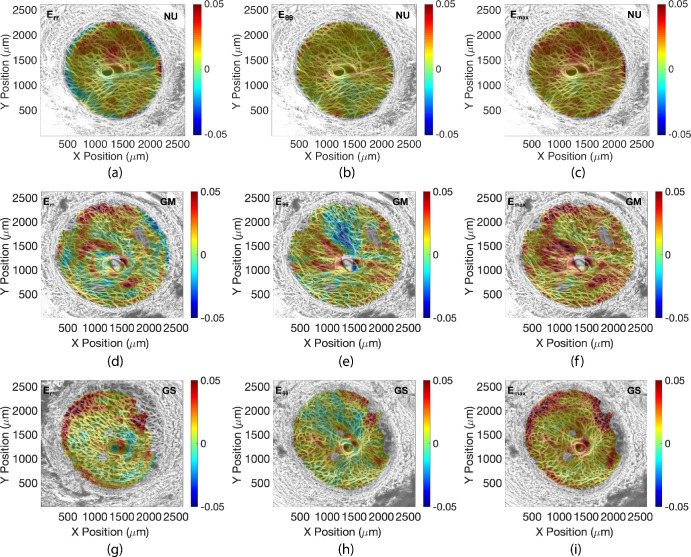
Comparison of strain within the LC of eye 6 (normal undamaged), eye 17 (glaucoma undamaged), and eye 14 (glaucoma severely damaged) for an inflation of 5 to 45 mm Hg. Eye 2: (A) Err, (B) Eθθ, (C) Emax; eye 17: (E) Err, (E) Eθθ, (F) Emax; and eye 14: (G) Err, (H) Eθθ, (I) Emax. Holes in the strain color contours were regions that either had poor correlation coefficients or high displacement error estimates. These were removed from the strain calculations.